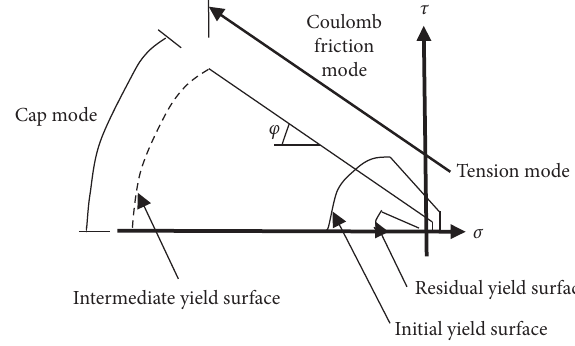
Figure 5: Coulomb friction interface model